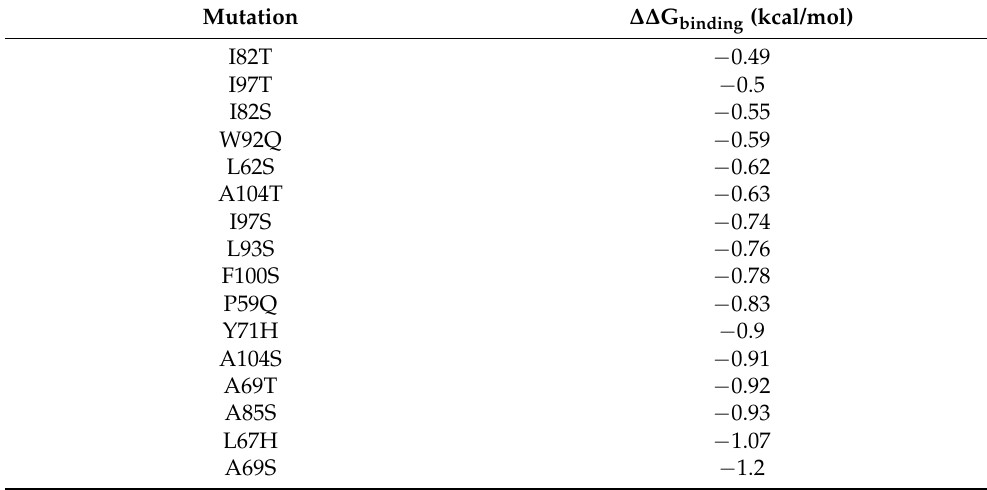
Table 9. M protein mutations that resulted in a stabilization gain of the homodimer